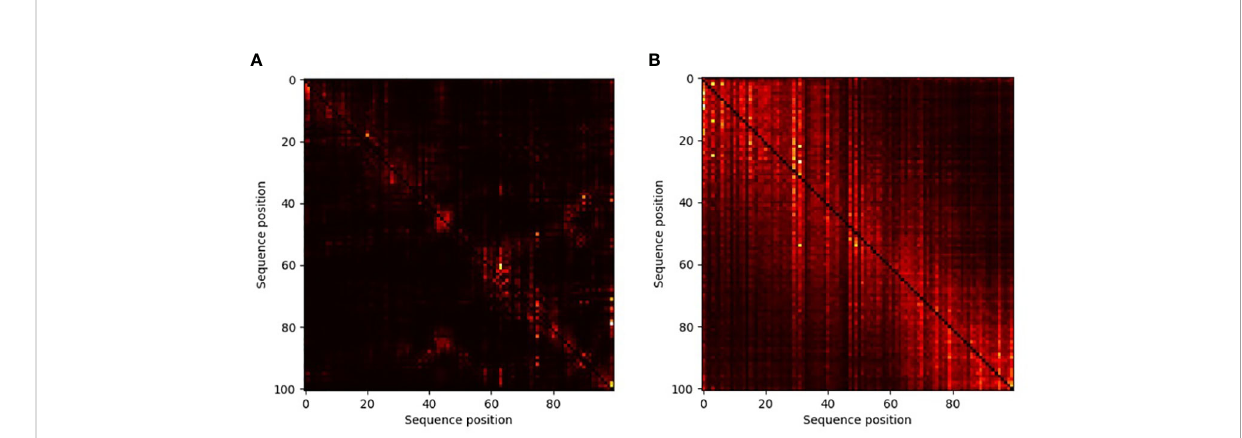
FIGURE 5 Attention maps of non-T3Es (A) and T3Es (B) demonstrating the effect of different positions in the amino acids sequence in the embedding process. The lighter the color, the more signi fi cant the interaction is. In these maps, each column (j) is a position in the sequence, and each entry (i,j) is the effect of position i on position j. The diagonal, which re fl ects the effect of each position on itself, was blacked